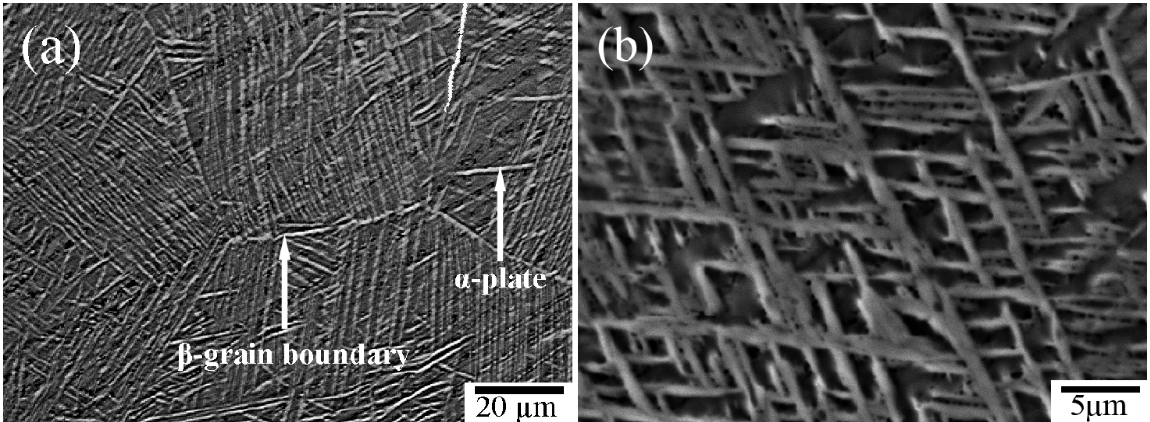
Figure 1. β -quenched microstructure: ( a ) OM image ( b ) BSE image. The DSC curve of N36 zirconium alloy, evaluated by using Proteus thermal analysis